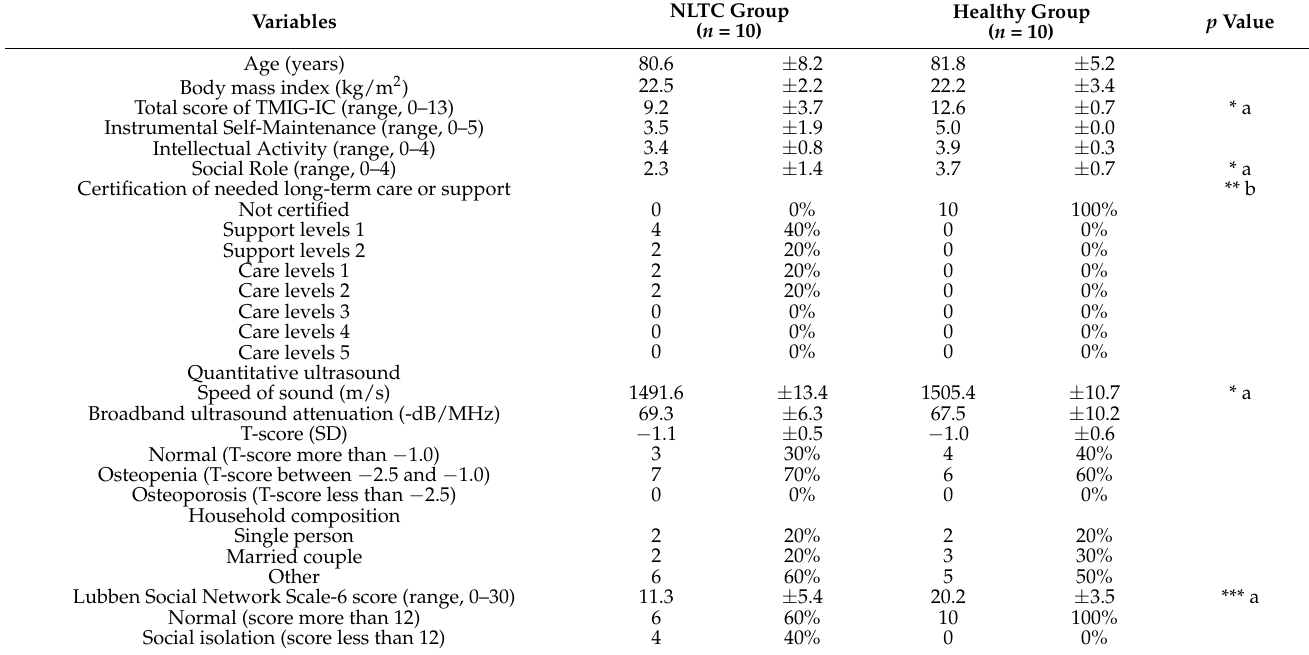
Table 1. Baseline characteristics of the participants.